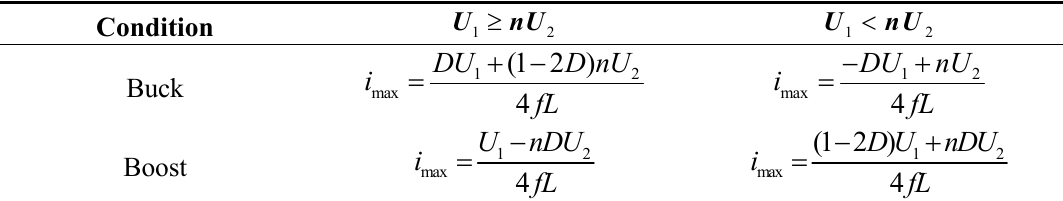
Table 2. The peak currents of leakage inductance with ESPS